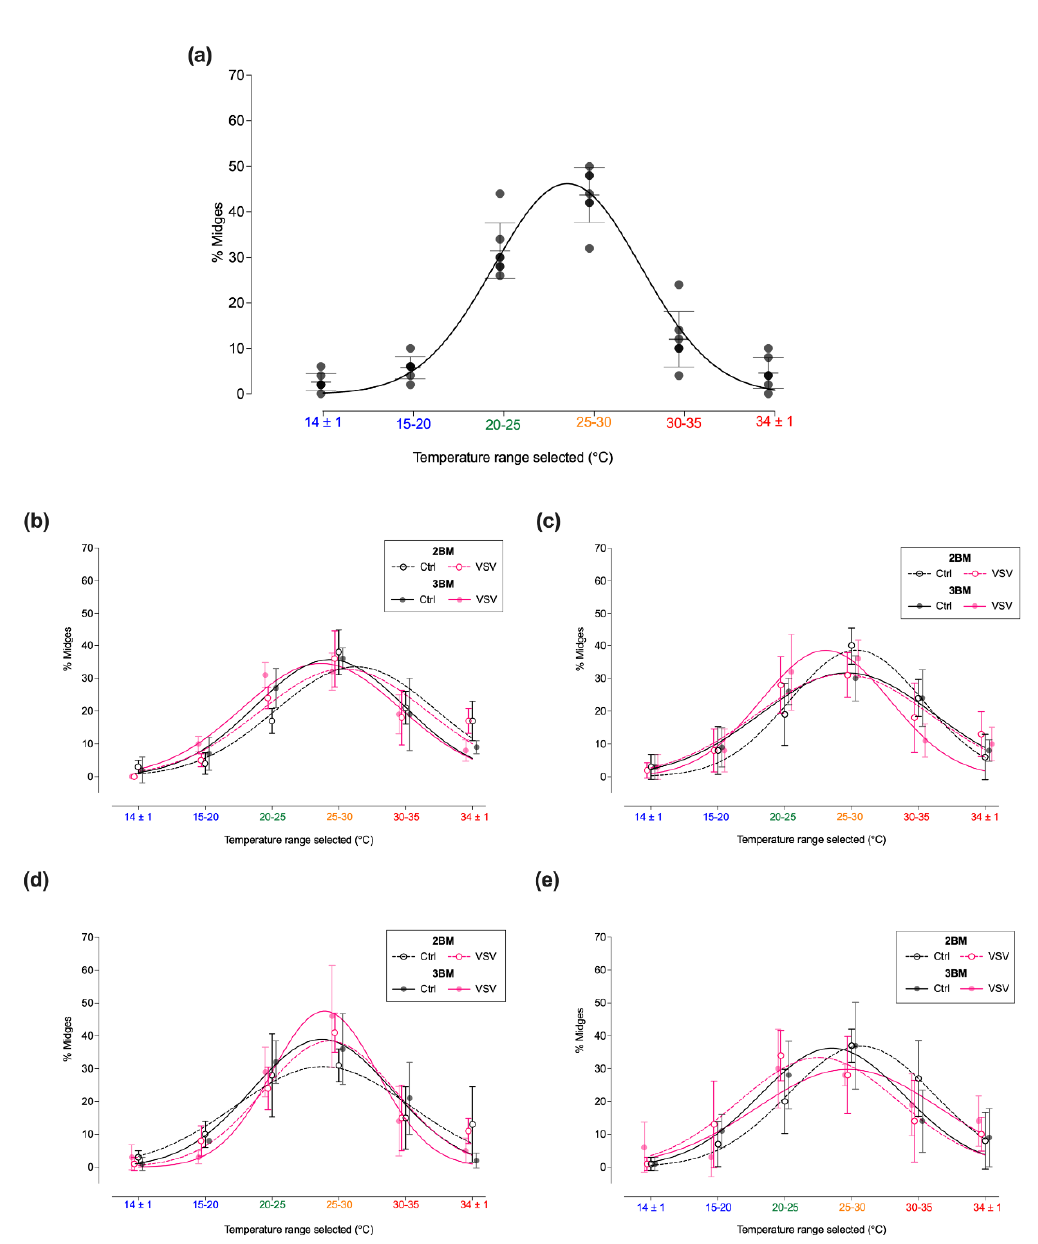
Figure 5. Culicoides resting temperature preference after engorgement. Mean final distribution of midges across the thermal gradient arena after engorgement with the ( a ) first blood meal (1BM and VSV-BM combined) and second (2BM) and third (3BM) blood meals in midges held at ( b ) 20 °C, ( c ) 25 °C, ( d ) 30 °C, and ( e ) 35 °C. Error bars represent the standard deviation (SD).